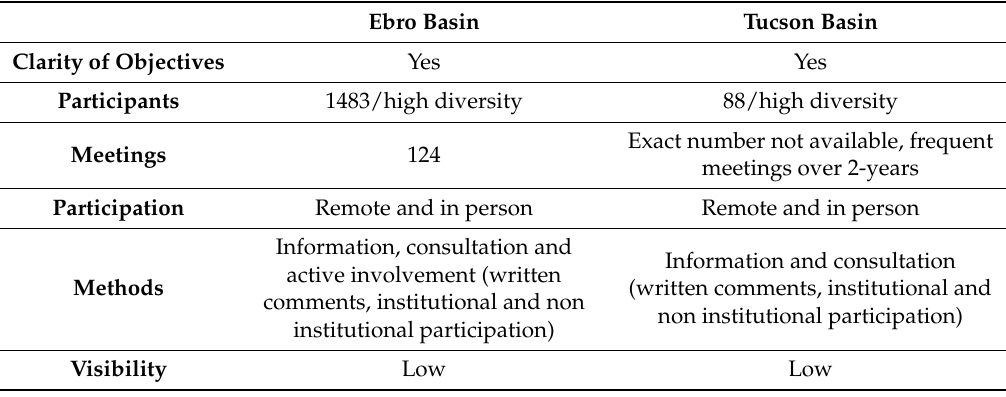
Table 7. Comparison of case studies’ participatory